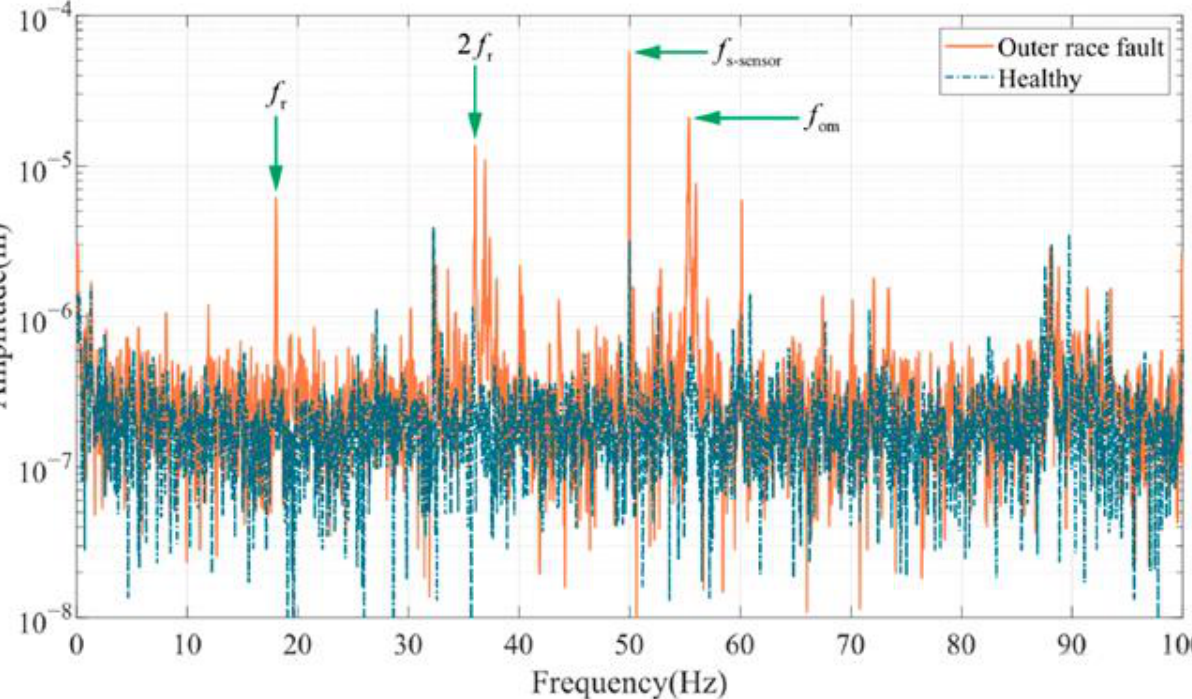
Figure 6. The comparison of harmonics in stator current to diagnose healthy and outer race bearing conditions [15].